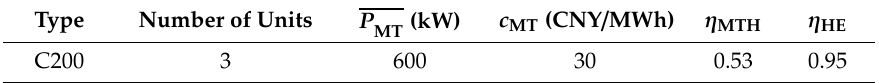
Table 6. Specification of MTs.